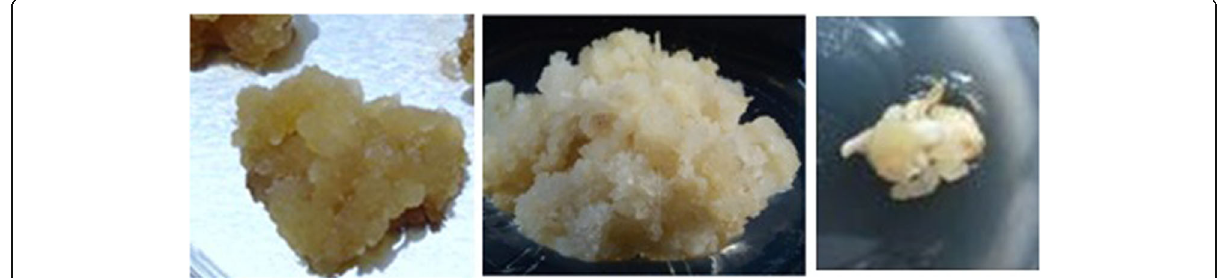
Fig. 7 Browning of the calli on elicitation with L.